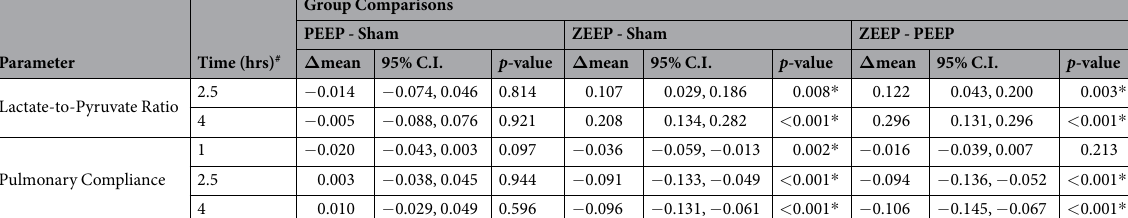
Table 2. Summary of post-hoc analysis performed using the Tukey honest significant difference test, performed when the results of the one-way ANOVA test (with Bonferroni adjustment for four time points α = 0.05/4 = 0.0125) for each time point was significant. Initial two-way ANOVA of the average lactate- adj . to-pyruvate ratio showed discrimination among groups (F 2,74 = 8.242, p < 0.001) and pyruvate injections (F 3,74 = 7.023, p < 0.001). The average lactate-to-pyruvate ratio was similar among groups both at healthy baseline (F 2,18 = 0.648, p = 0.535) and 1 hour after acid/saline instillation (F 2,18 = 0.514, p = 0.513), but was significantly different 2.5 hours (F 2,14 = 8.843, p = 0.003) and 4 hours (F 2,14 = 5.533, p < 0.001) after the instillation of acid/saline. The initial ANOVA of the pulmonary compliance (C dyn ) showed significant inter-group difference (F 2,74 = 16.56, p < 0.001). C dyn was also significantly different among groups 1 hour (F 2,18 = 7.866, p = 0.003), 2.5 hours (F 2,18 = 16.1, p < 0.001) and 4 hours (F 2,18 = 20.8, p < 0.001) after acid/saline instillation. ( # Time from the instillation of acid/saline).